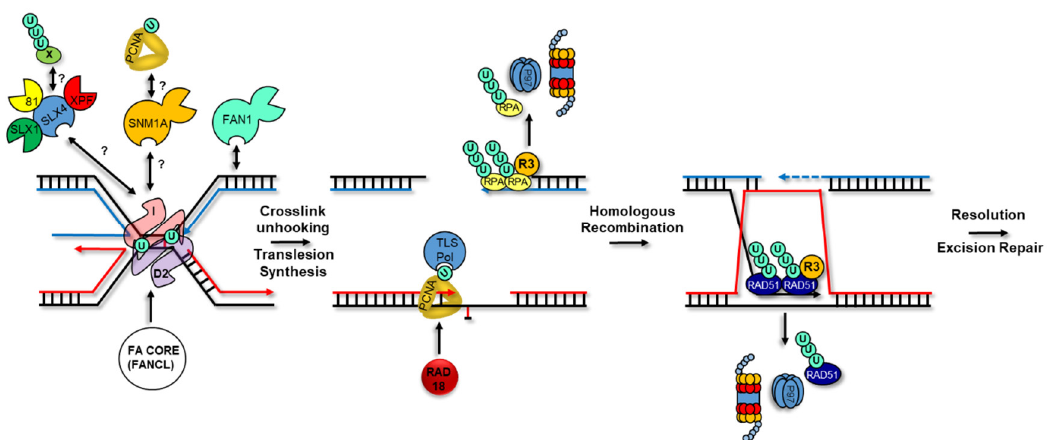
Figure 4. Ubiquitylation and the Fanconi Anemia Cross‐link Repair Pathway. Upon cross‐link detection, the FANCD2/I (D2/I) complex is activated by ATR phosphorylation and FA core complex ubiquitylation. This ubiquitylation promotes the cross‐link unhooking step via the recruitment of nucleases containing ubiquitin binding‐domains. These nucleases include SLX1, XPF and MUS81 (81) which are bound to the scaffold SLX4 ubiquitin‐binding protein, SNM1A and FAN1. The mode of recruitment of SLX4 to ICLs is currently unclear and may depend on still unknown ubiquitylated factors (X). After lesion unhooking is completed, translesion polymerases are recruited to synthesize DNA on the parental duplex containing the lesion and the double‐stranded break on the other duplex is resected to promote HR. RFWD3 (R3) associates with and ubiquitylates the ssDNA‐binding RPA and the RAD51 recombinase and promotes their VCP/p97 and proteasome-dependent removal and degradation to drive HR to